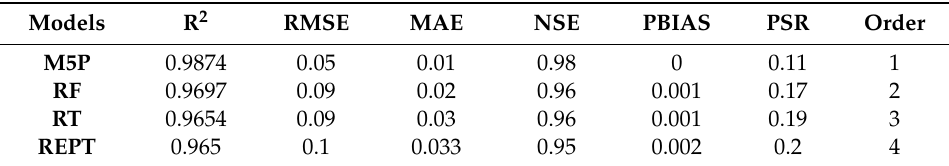
Table 2. Comparison of model prediction power.